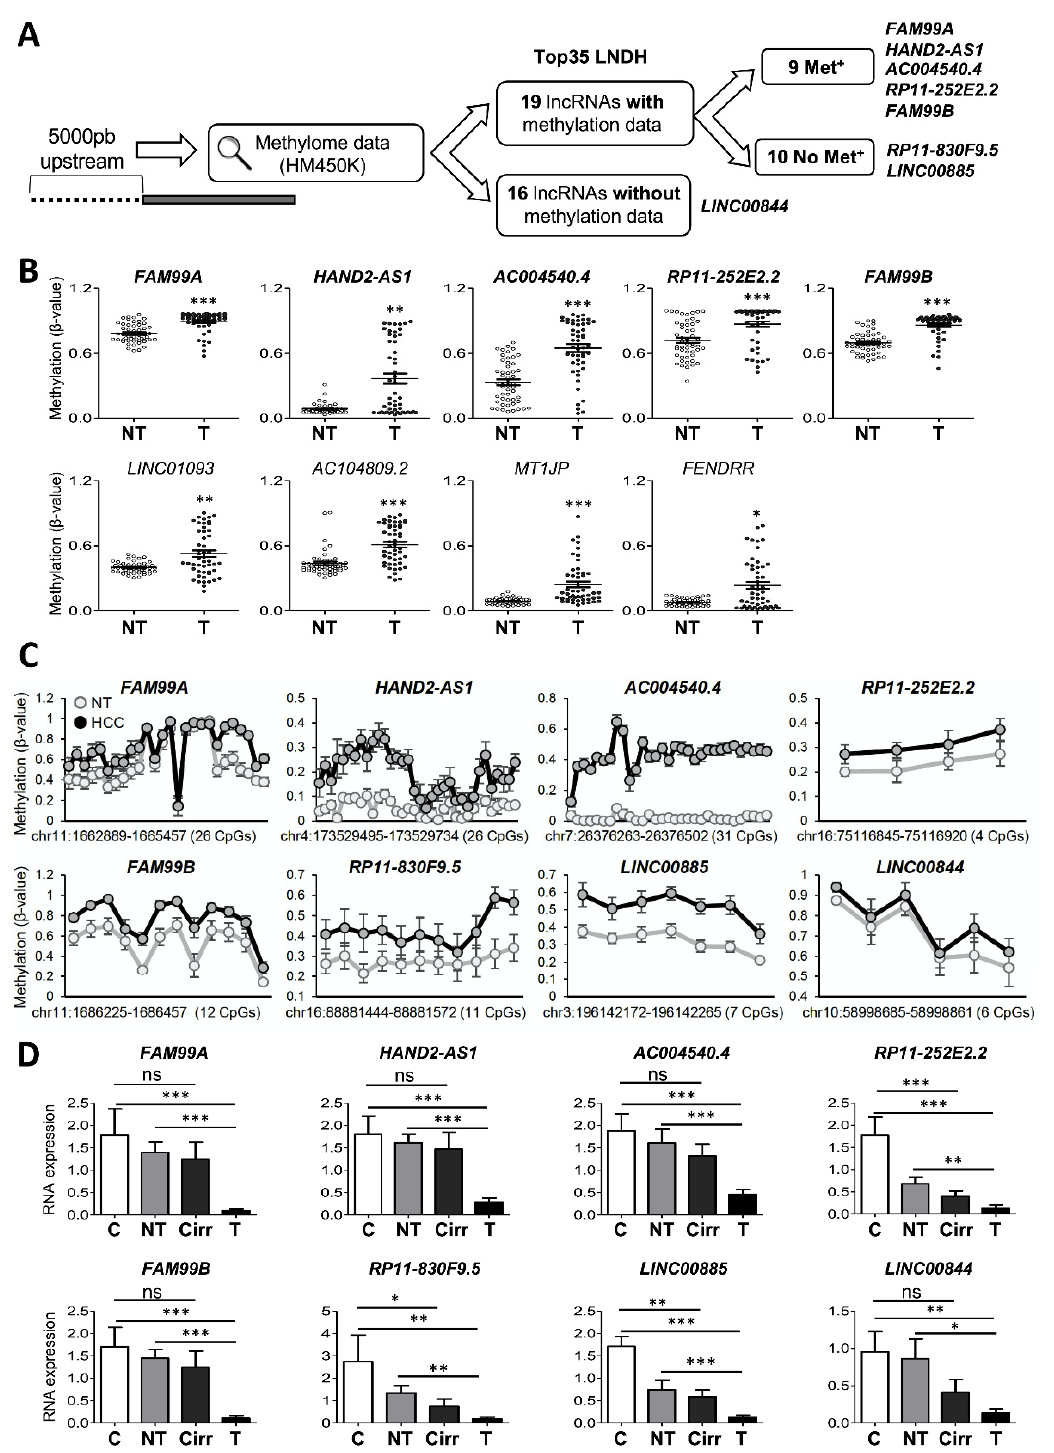
Figure 2. Evaluation of promoter DNA methylation levels of lncRNAs within the Top35 LNDH. ( A ) Schematic representation of the available methylation data for the promoter region (5000bp up- stream lncRNA TSS) of the Top35 LNDH included in the Infinium HumanMethylation450 BeadChip (HM450K). Among the 19 lncRNAs with at least one promoter CpG analyzed in the array, 9 were hypermethylated (Met + ). The eight lncRNAs selected for further validation by RT-qPCR and targeted bisulfite sequencing are indicated. ( B ) DNA methylation levels ( β -values) of the most sig- nificantly hypermethylated CpG found in the promoter region of the mentioned nine lncRNAs in the 50 patients from the LIHC TCGA cohort for which both peritumoral (NT) and HCC tumor (T) samples were available. The average is indicated as a line. ( C ) Graphs reporting DNA methylation levels ( β -values) obtained by targeted bisulfite sequencing of the promoter regions of the eight se- lected lncRNAs (see A) in peritumoral and HCC tissues (n = 7). Note that for all lncRNAs analyzed,